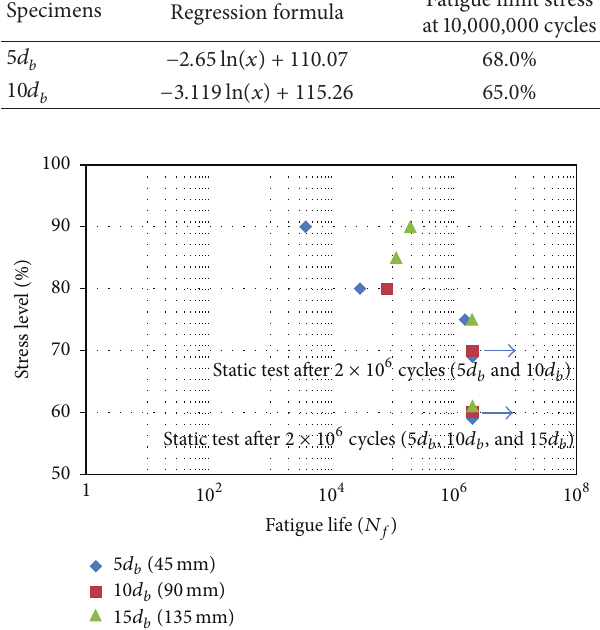
state of bonding is useful in designing and analyzing flexural reinforced concrete members, especially those reinforced with GFRP reinforcing bars. Table 3 shows the estimated fatigue limit stress by regression